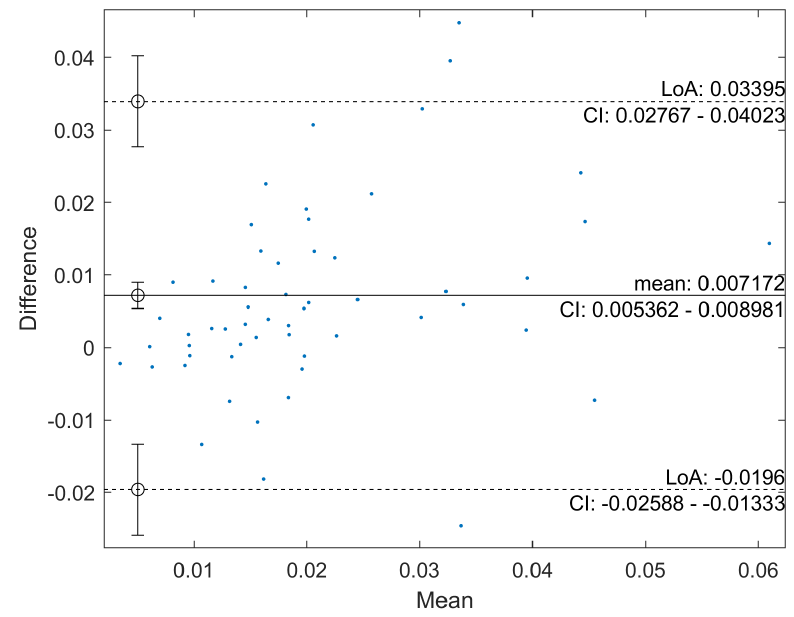
Figure 16. Bland–Altman plot shows the agreement between spatiotemporal features (vertical deviation in the position of the horizontal shoulder line between ShoulderLeft and ShoulderRight joints) for subjects calculated using RealSense and IK analysis. The reference line at the mean is represented by the solid line, and the top and lower limits of agreement are represented by the two black dashed lines.